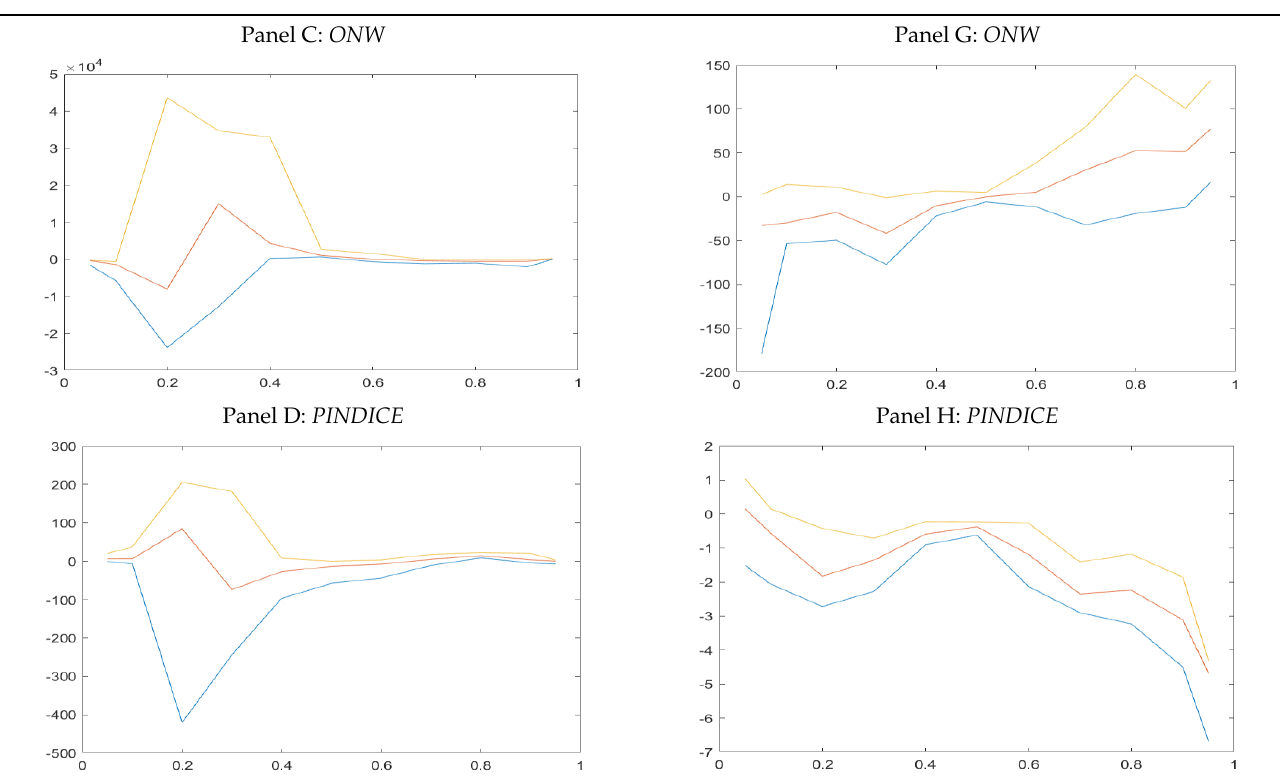
Table 6. Cont. Panel C: